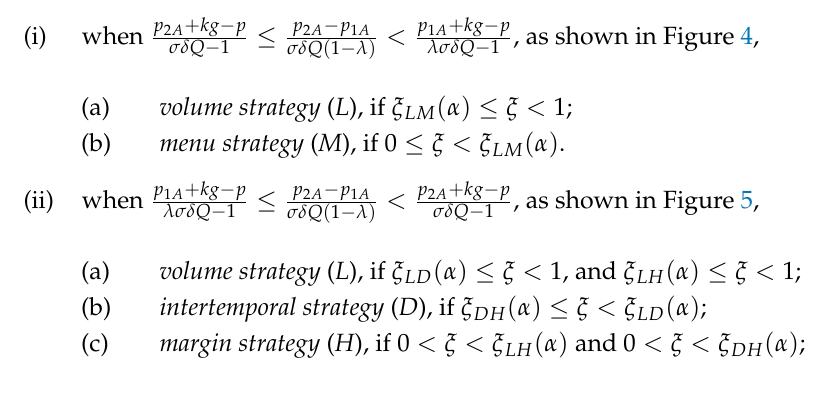
(cid:3408) (cid:3043) (cid:3117)(cid:3250) (cid:3397)(cid:1863)(cid:1859) (cid:2879)(cid:3043) when (cid:3043) (cid:3118)(cid:3250) (cid:2879)(cid:3043) (cid:3117)(cid:3250) . (cid:3097)(cid:3083)(cid:3018)(cid:4666)(cid:2869)(cid:2879)(cid:3090)(cid:4667) (cid:2870) (cid:3090)(cid:3097)(cid:3083)(cid:3018)(cid:2879)(cid:2869)